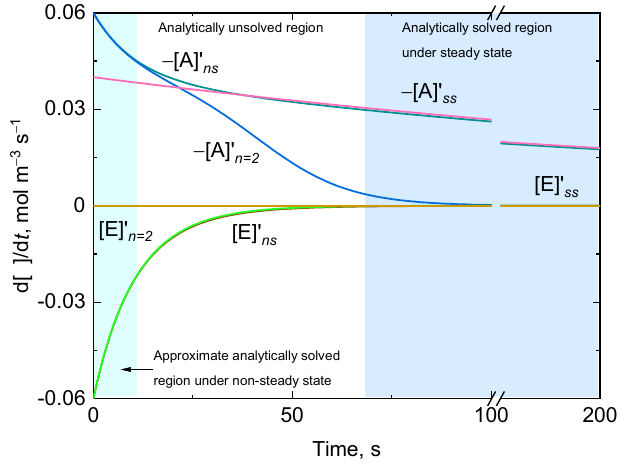
Figure 4. Representative numerical (subscript ns ) and approximate analytical (subscript n = 2 ) solutions of the time-dependent variation of the reaction rate for the substrate A undergoing disproportionation and one of the active enzymes states, E, of an enzyme-catalyzed ping-pong reaction in which the substrate–enzyme complexes do not accumulate. The numerical solutions ( ns ) for − [ A ] (cid:48) and [ E ] (cid:48) are shown together with two approximate analytical solutions for − [ A ] (cid:48) and [ E ] (cid:48) in two different domains: the pale-green domain for which the steady-state approximations are not invoked around t = 0 (i.e., − [ A ] (cid:48) n = 2 and n = 2 ) and the pale-blue domain for which the steady-state ( ss ) approximation is invoked (i.e., − [ A ] (cid:48) ss and [ E ] (cid:48) ss ). The intermediate non-shadowed domain is not analytically solved. The equality − [ E ] (cid:48) = [ F ] (cid:48) holds for any domain. Initial conditions: [ A ] 0